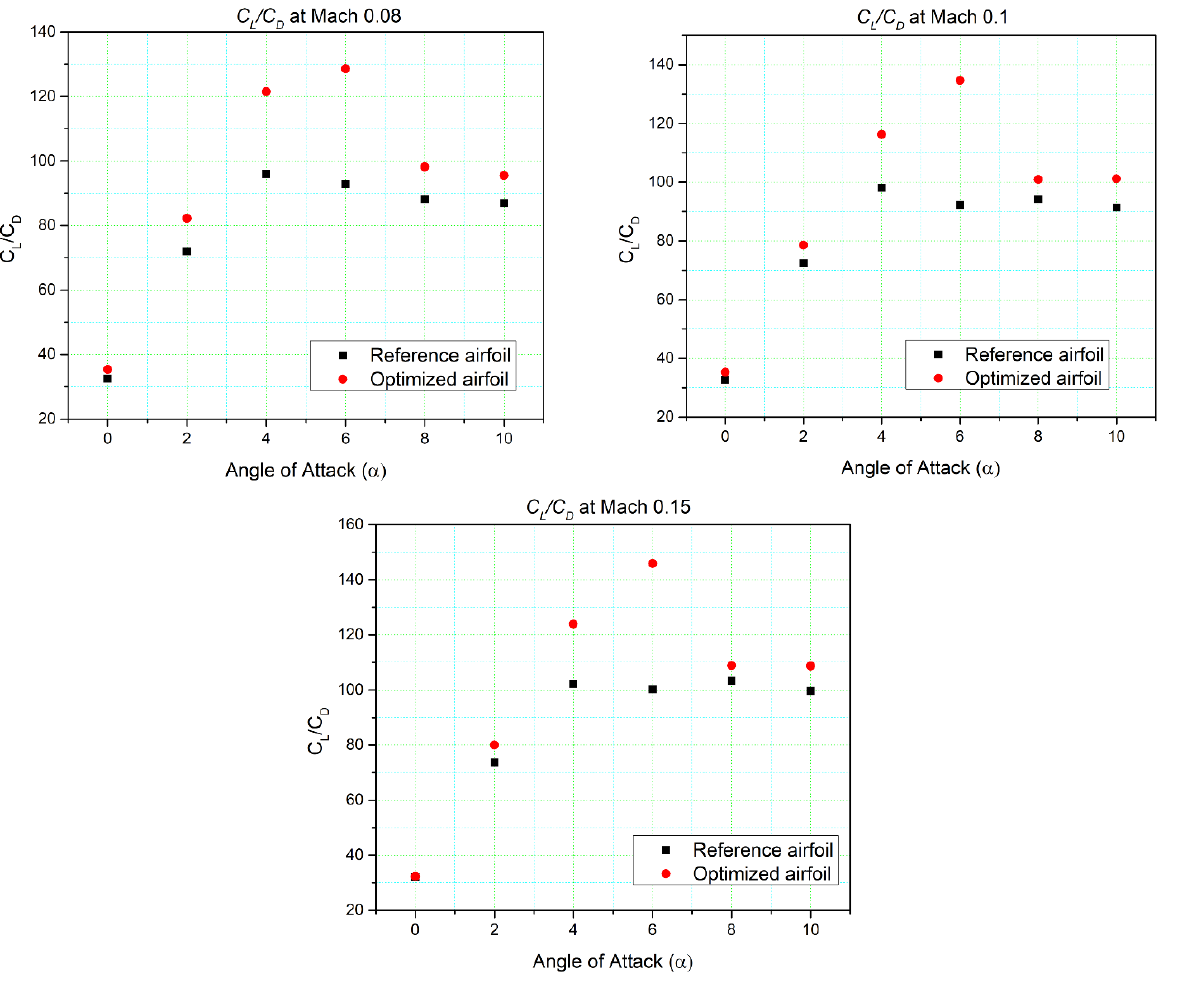
Figure 8. Comparison of CL/CD for the reference and optimized airfoils at different angles of attack and Mach numbers 0.08, 0.10, and 0.15. The lift-to-drag ratios at these three Mach numbers show that the best improvements in efficiency are obtained at angles of attack of 4 to 6°.